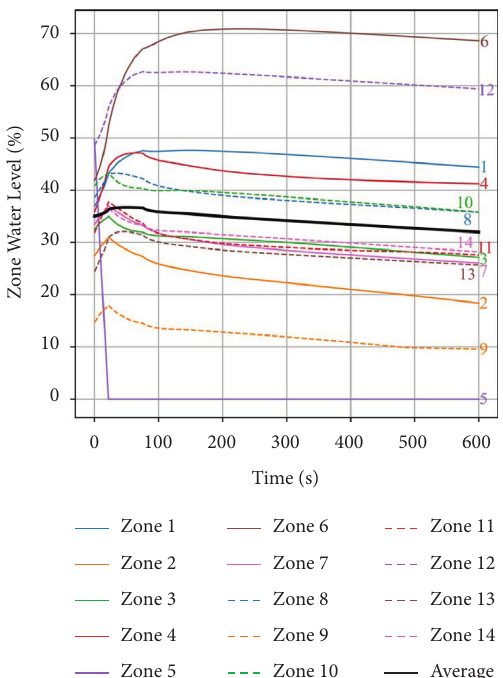
Figure 17: Liquid zone levels for zone control failure transient.